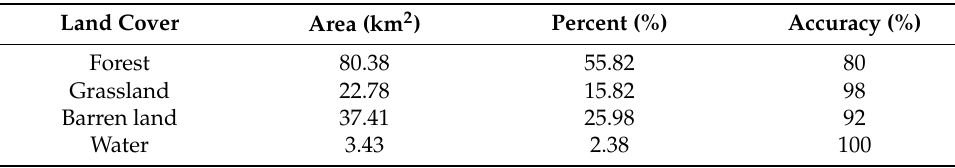
Table 1. The areas for each land cover and their classification